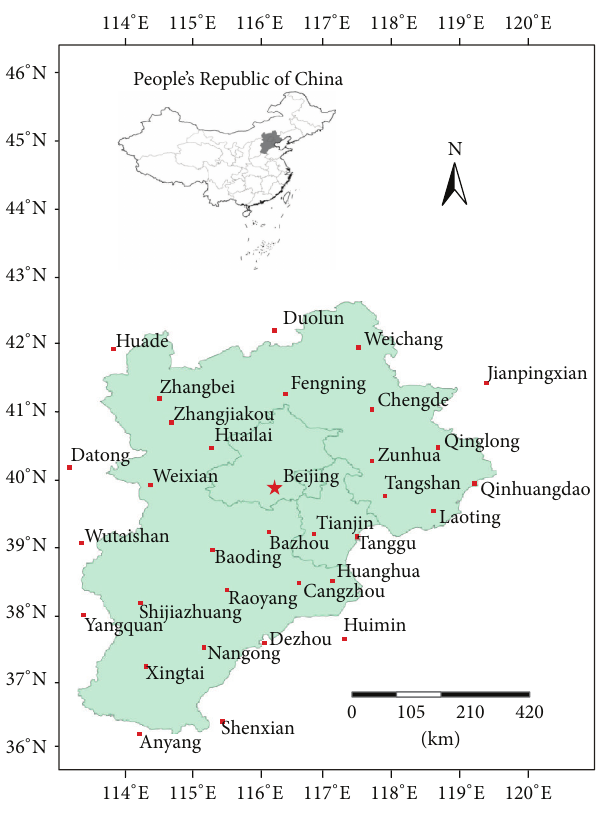
Figure 1: Spatial distribution of the 33 meteorological stations in Beijing-Tianjin-Hebei metropolitan areas